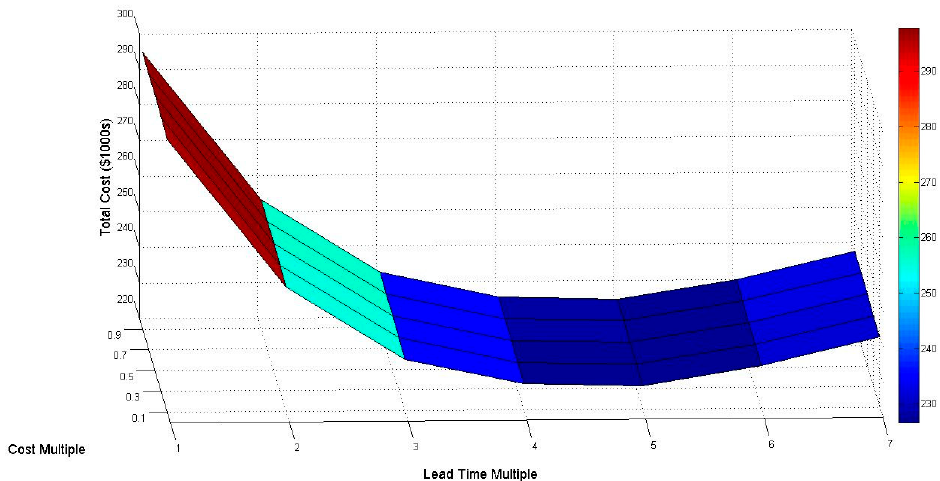
Figure 5. Results for the medium instance set.